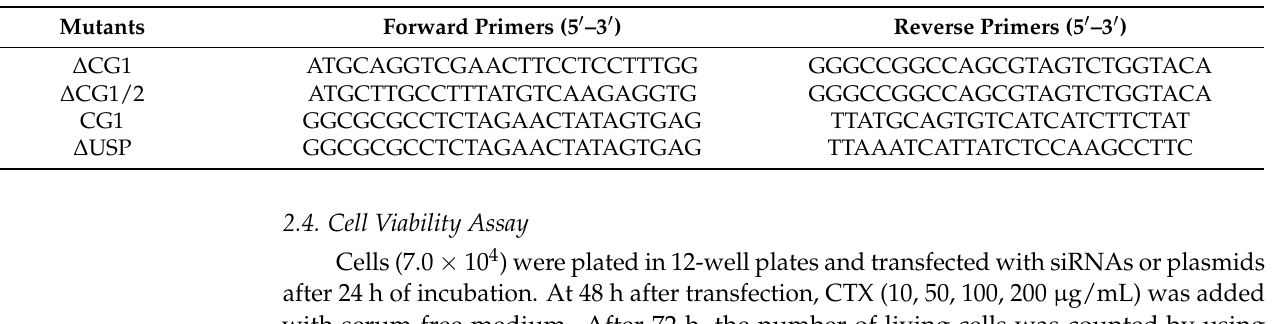
Table 1. Primers used to construct CYLD deletion